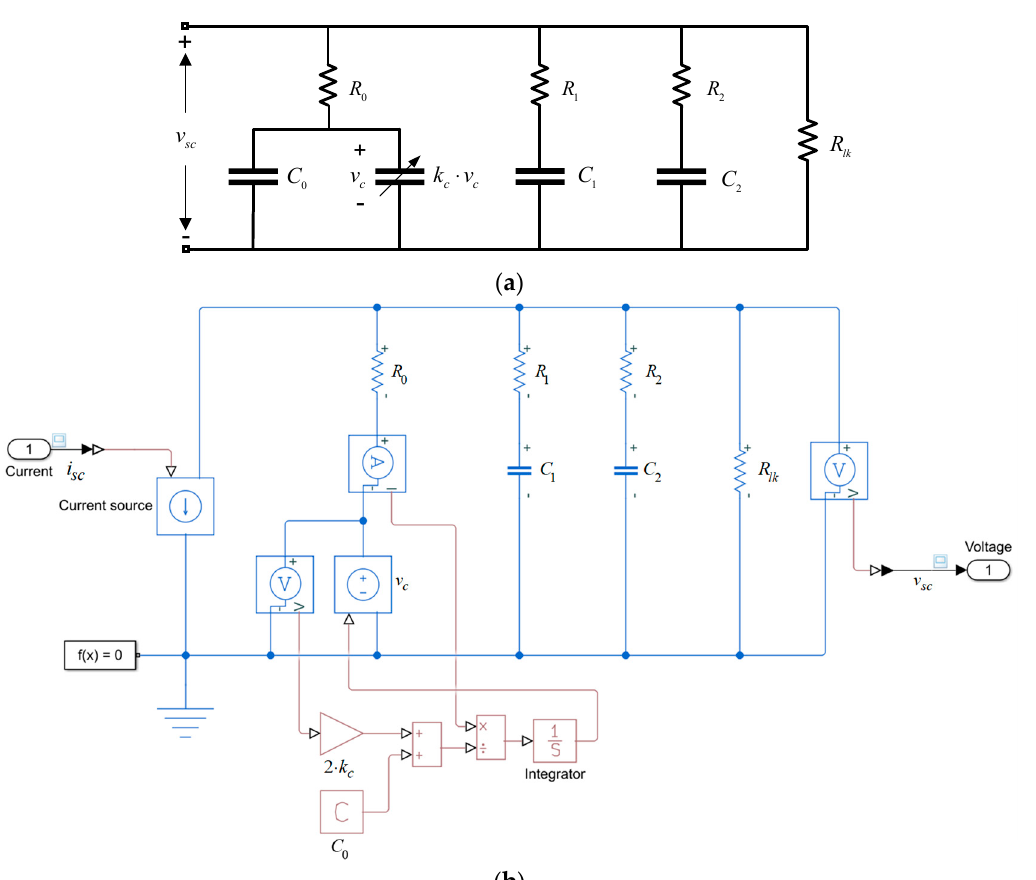
Figure 2. Zubieta model: ( a ) Electric circuit; ( b ) Simscape implementation.